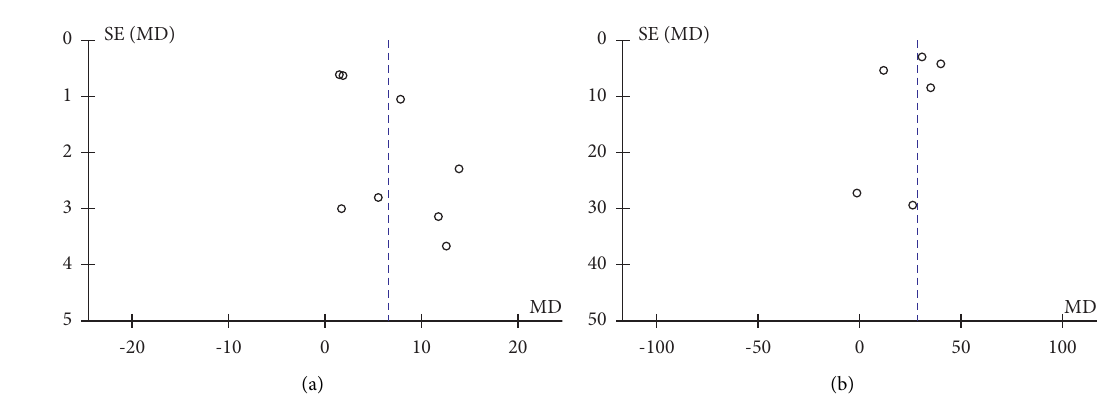
Figure 9: Funnel plot for potential publication